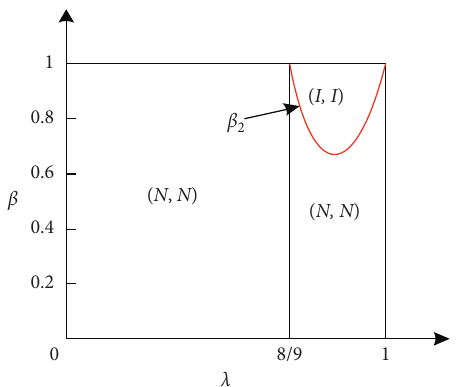
Figure 9: The two retailers’ optimal strategies about information acquisition and price